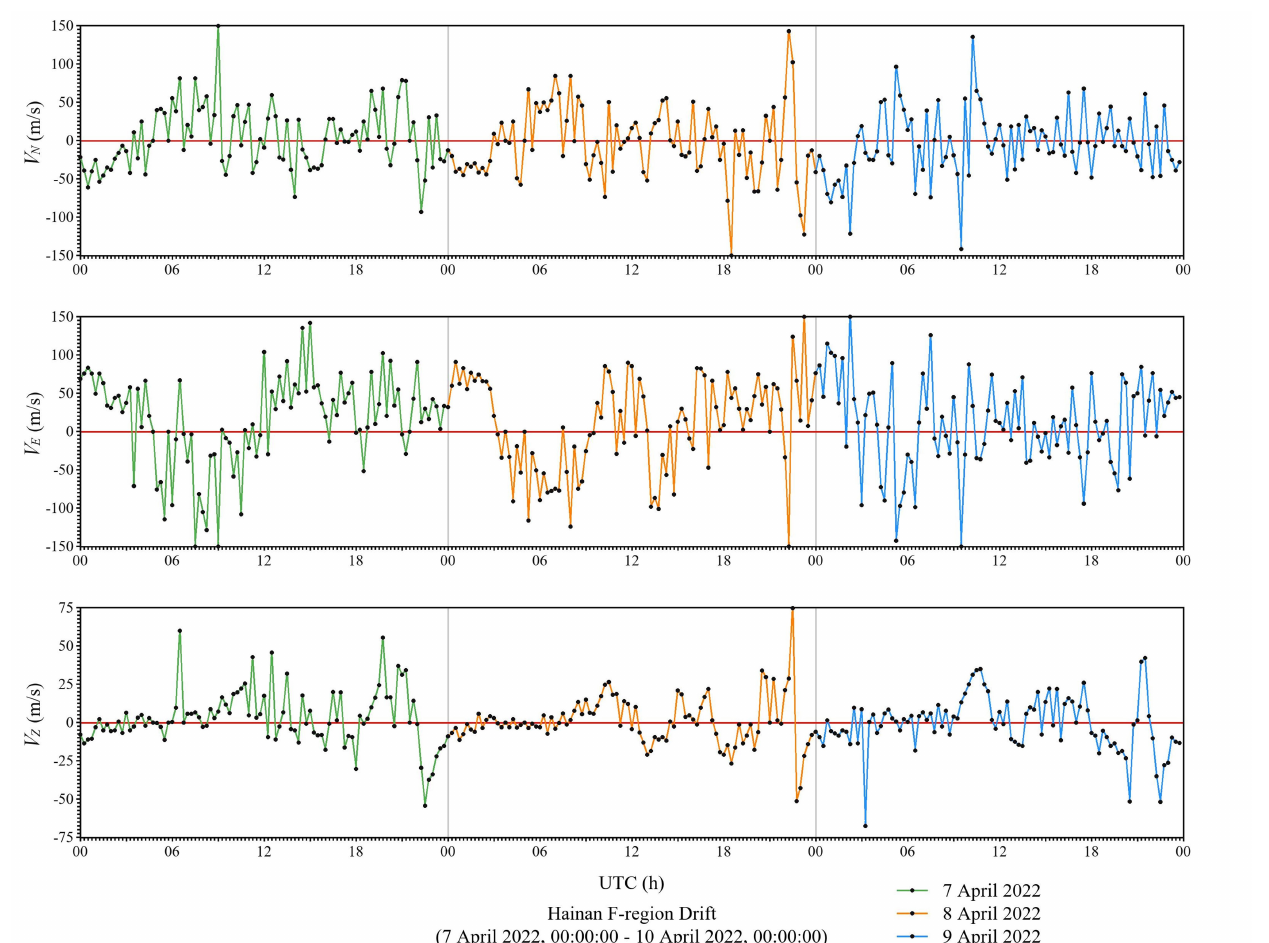
Figure 12. Statistics of the F-region drift velocity in Hainan from 7 April 2022, 00:00:00 to 10 April 2022, 00:00:00 in